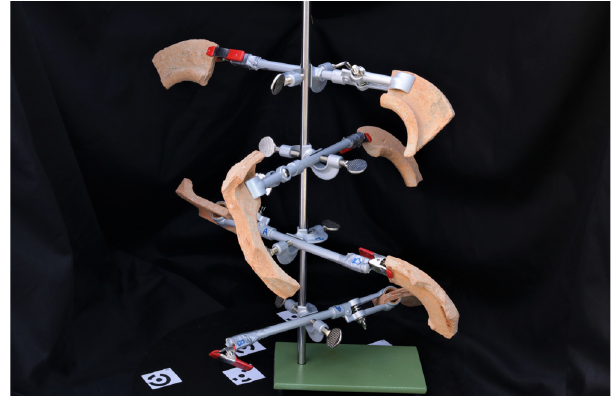
Figure 7: “ Pottery tree ” with sherds held by